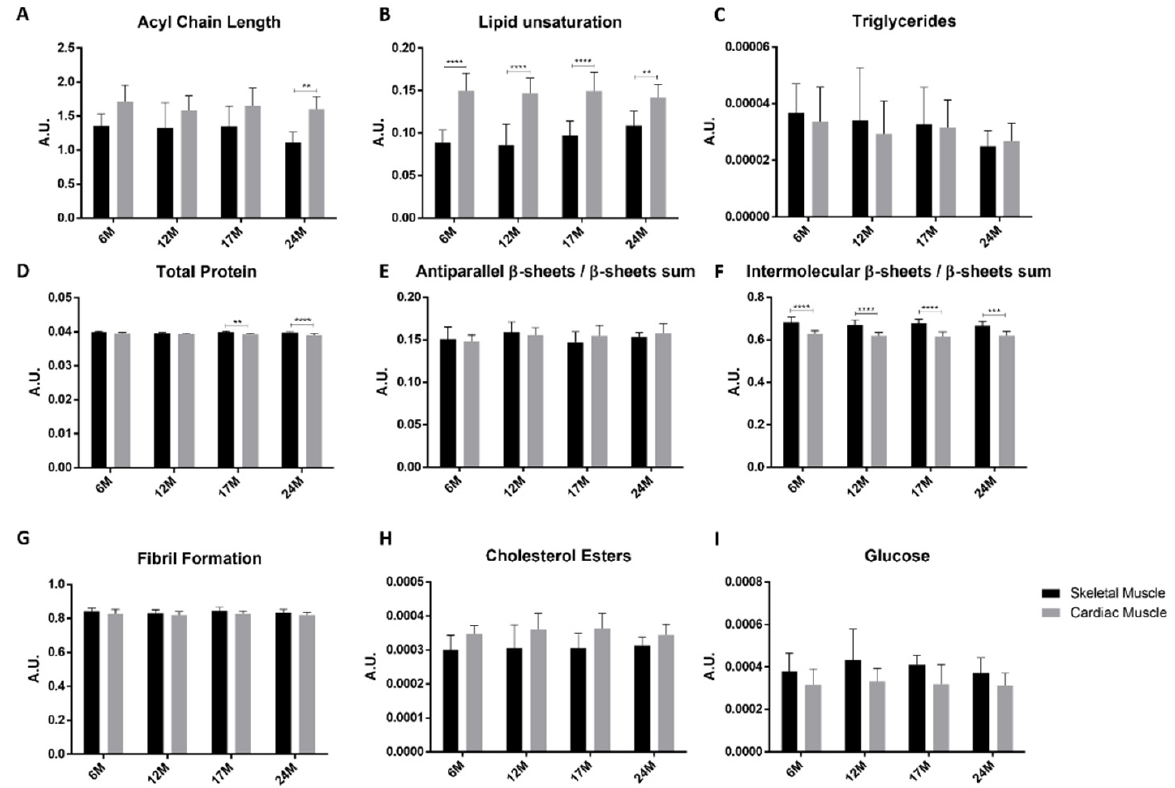
Figure 2. Analysis of peak intensities of cardiac and skeletal muscle spectra. ( A ) Acyl chain length, calculated using CH 2 and CH 3 peak intensities (ratio I 2851+2922 /I 2959+2871 ); ( B ) Lipid unsaturation levels, calculated using the ratio between olefinic band and CH 2 bands (ratio I 3013 / I 2851+2922 ); ( C ) The levels of triglycerides, calculated using intensity of C=O band at 1741 cm − 1 ; ( D ) Total protein levels, calculated by the sum of Amide I and Amide II peaks (I Amide II /I Amide I ); ( E ) Ratio of antiparallel β -sheet/ β -sheets sums, calculated using I 1693 /I 1693+1682+1628 ; ( F ) Ratio of intermolecular β -sheets/ β -sheets sums, calculated using I 1628 /I 1693+1682+1628 ; ( G ) Fibril formation, calculated using Amide I and Amide II peak intensities (ratio I Amide II /I Amide I ) using baseline-corrected, area-normalized and non-derived spectra; ( H ) Cholesterol ester levels, calculated using the intensity of peak at 1169 cm − 1 ; and ( I ) Glucose levels, calculated using the intensity of peak at 1045 cm − 1 . Data are expressed as mean ± SD. ** p < 0.01; *** p < 0.001; **** p < 0.0001.